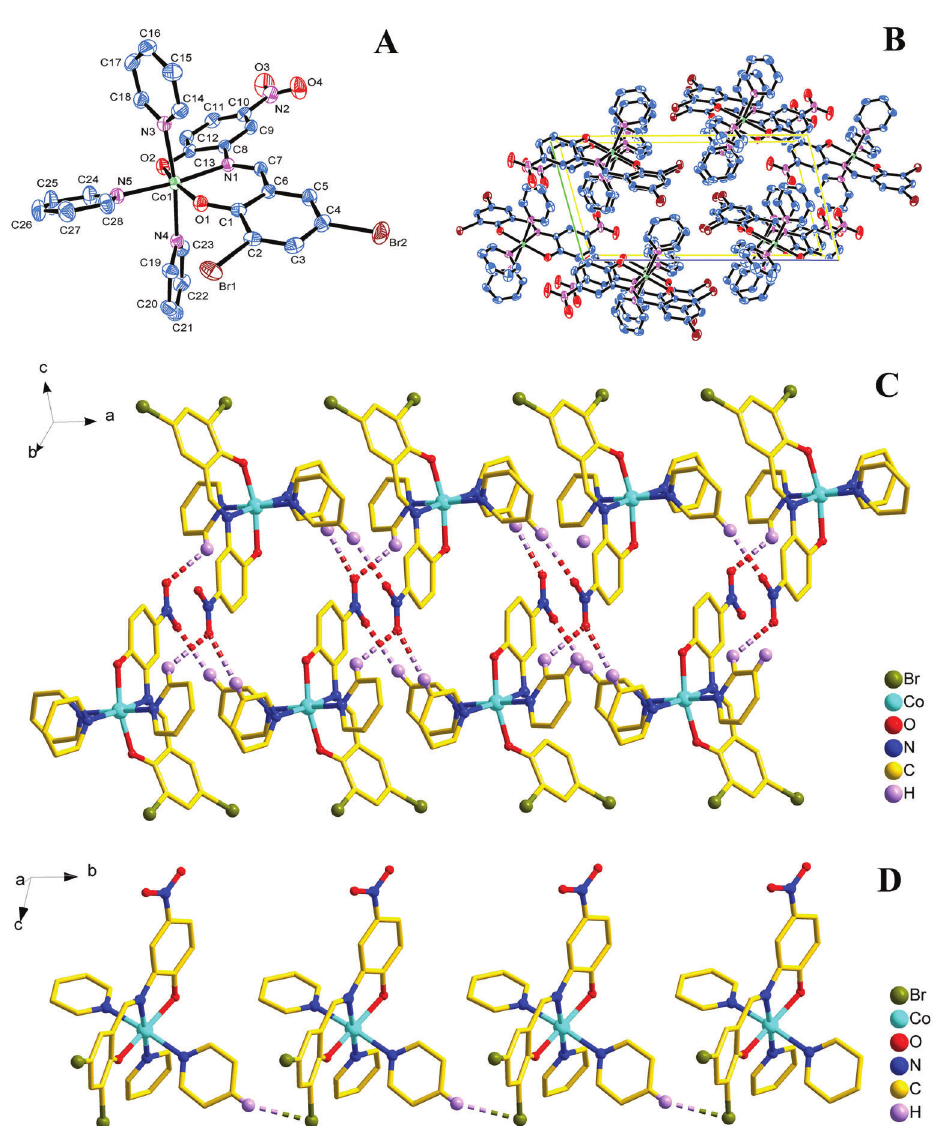
Figure 3. A , Molecular structure of compound 2 (Py 3 CoL 2 ); B , packing of compound 2 in unit cell; C , 1D ribbon-like structure of compound 2 was formed by the C-H y O hydrogen bonding interaction, D , 1D chain-like structure of compound 2 was formed by the C-H y Br